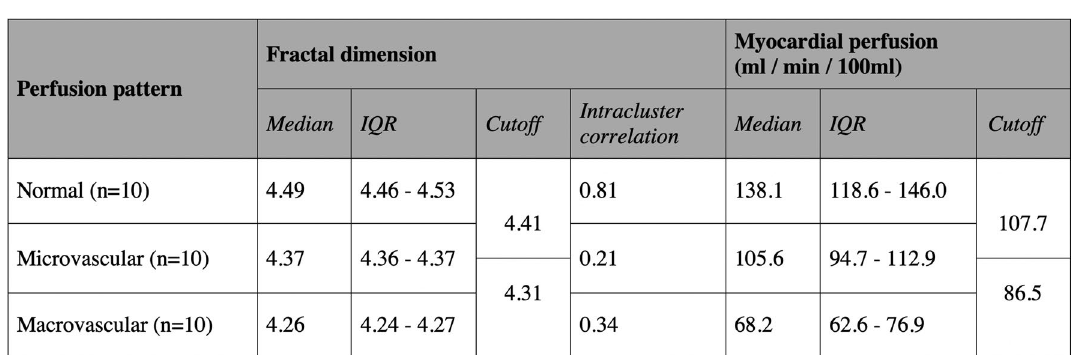
Figure 3. Boxplot of fractal dimension (FD) versus perfusion pattern ( A ) and myocardial perfusion (semiquantitative maximum upslope estimate ( B ). ( A ) Fractal dimension was significantly (p < 0.001) different between normal perfusion, microvascular and macrovascular ischemia patterns (thresholds see Table 3 and Results section). ( B ) Fractal dimension showed moderate linear correlation with perfusion, however with a relatively high variation in perfusion.